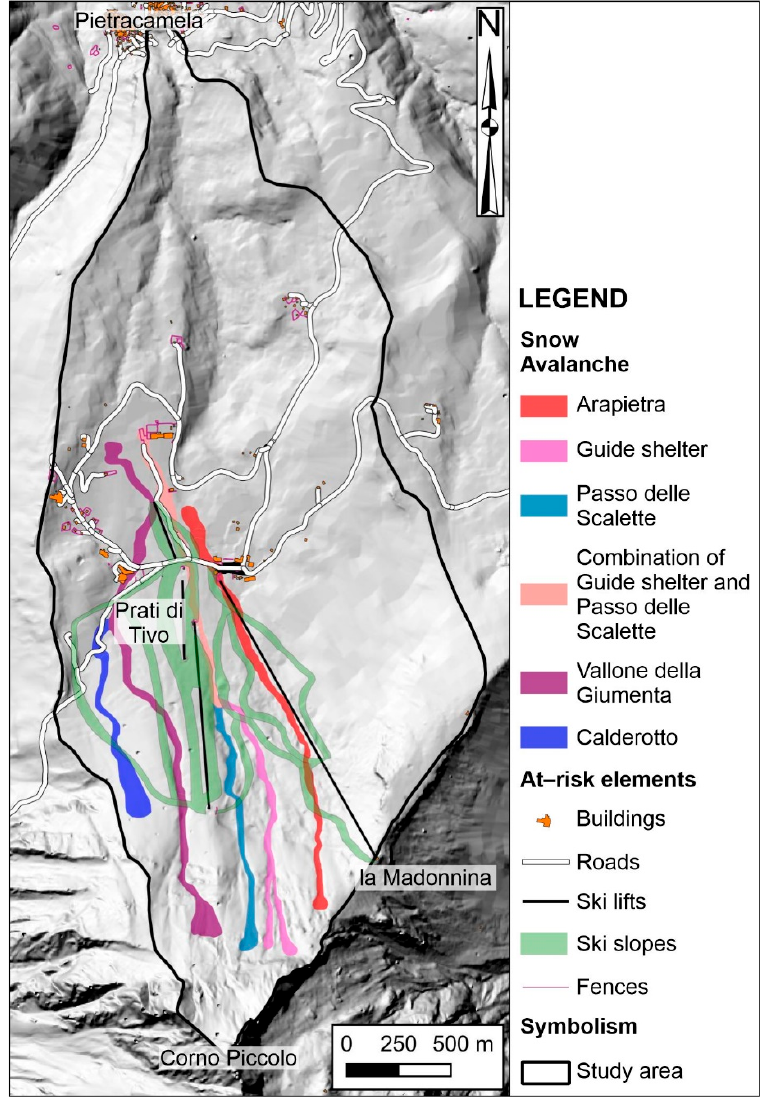
Figure 13. Snow avalanche paths recorded and mapped in the present study.